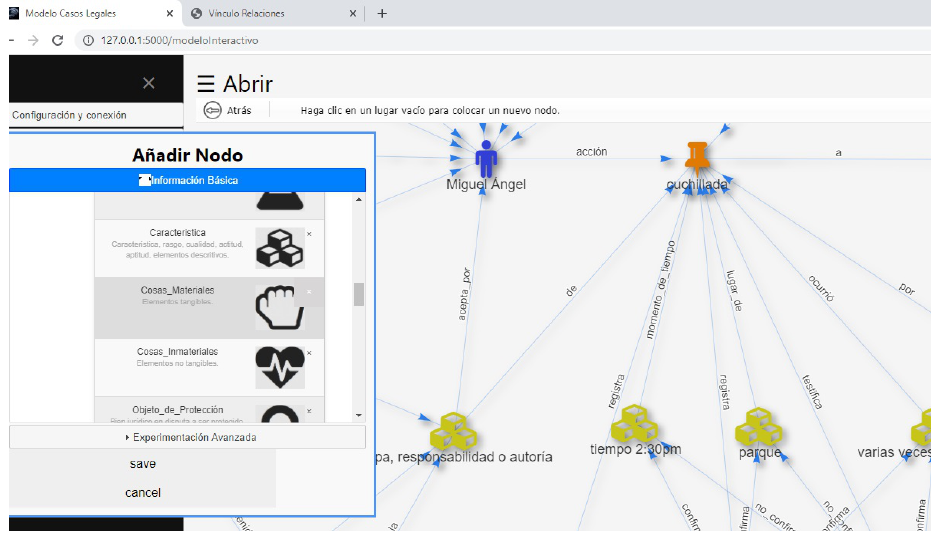
Figure 7. Example of an EGI showing a factual picture used to analyze the merits of a homicide case in real-time according to the graphical interpretation. Internally each image is translated into a node containing a set of attributes, and the arrows turn into edges containing a set of